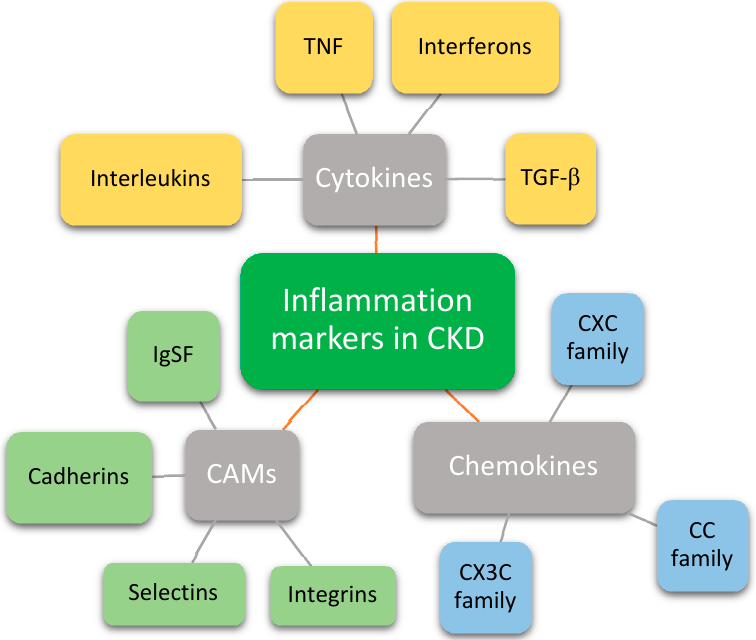
Figure 1. Groups of inflammation markers that have a role in chronic kidney disease. CKD—Chronic kidney disease; TNF—Tumor necrosis factor; TGF- β —Transforming growth factor beta; CAMs—Cell adhesion molecules; IgSF—Immunoglobulin superfamily.